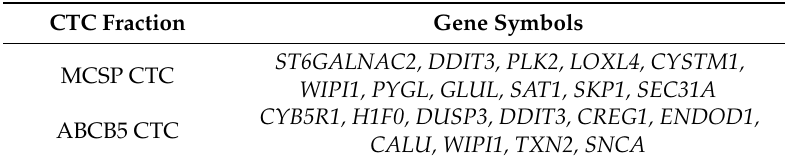
Table 4. Shared genes between CTC fractions and specifically expressed genes in single melanoma tumour